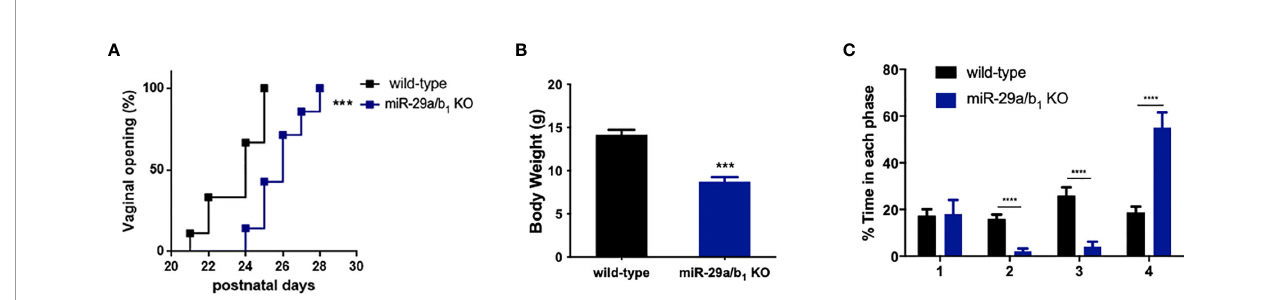
FIGURE 1 | Determination of pubertal onset and estrous cycle in miR-29a/b 1 KO females. (A) Pubertal onset was determined by vaginal opening in wild-type and miR-29a/b 1 KO mice (n=8). (B) Body weight of mice at the time of puberty onset (wild-type: 14.18 ± 0.5660, miR-29a/b 1 KO: 8.74 ± 0.5202, p=0.0001 , n=5). (C) Estrous cycle quantitative measurements on wild-type and miR-29a/b 1 KO females (1: p=0.9133 , 2-4 : p<0.0001 ). *** p < 0.001, **** p